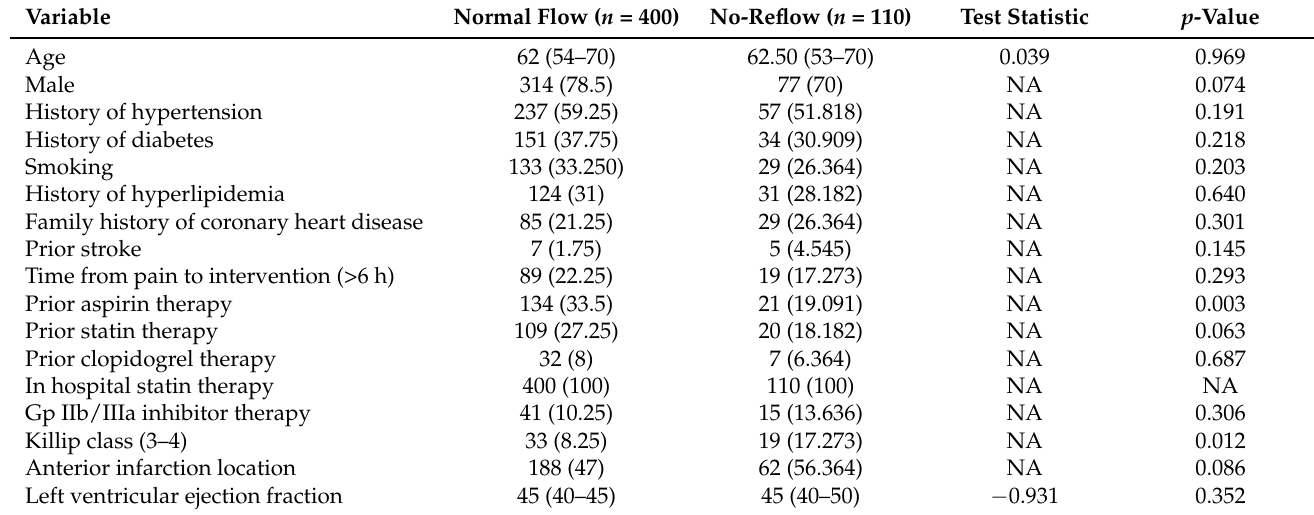
Table 2. Baseline characteristics of the